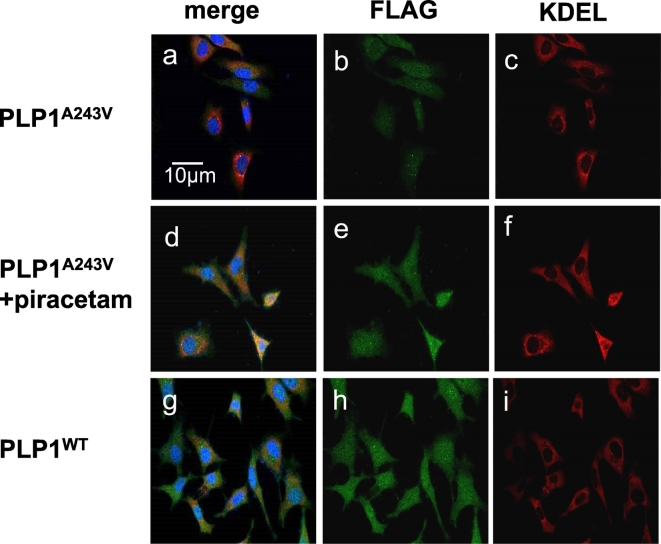
The results of an examination of the efficacy of piracetam with co-localization of PLP1 and proteins in the ER, images of MO3.13 cells stably expressing PLP1A243V-FLAG and PLP1WT-FLAG with anti-KDEL antibody (×600) are shown. PLP1A243V-FLAG and PLP1WT-FLAG are shown in green (b, e, h), and KDEL, which reflects ER localization (c, f, i), is shown in red. PLP1A243V proteins are weakly expressed mainly in the ER (a-c). After the addition of piracetam, PLP1A243V was localized throughout the intracellular region (d-f). Nuclei stained with Hoechst are shown in blue. a-c: PLP1A243V, d-f: PLP1A243V with piracetam, and g-i: PLP1WT. (For interpretation of the references to colour in this figure legend, the reader is referred to the web version of this article.)